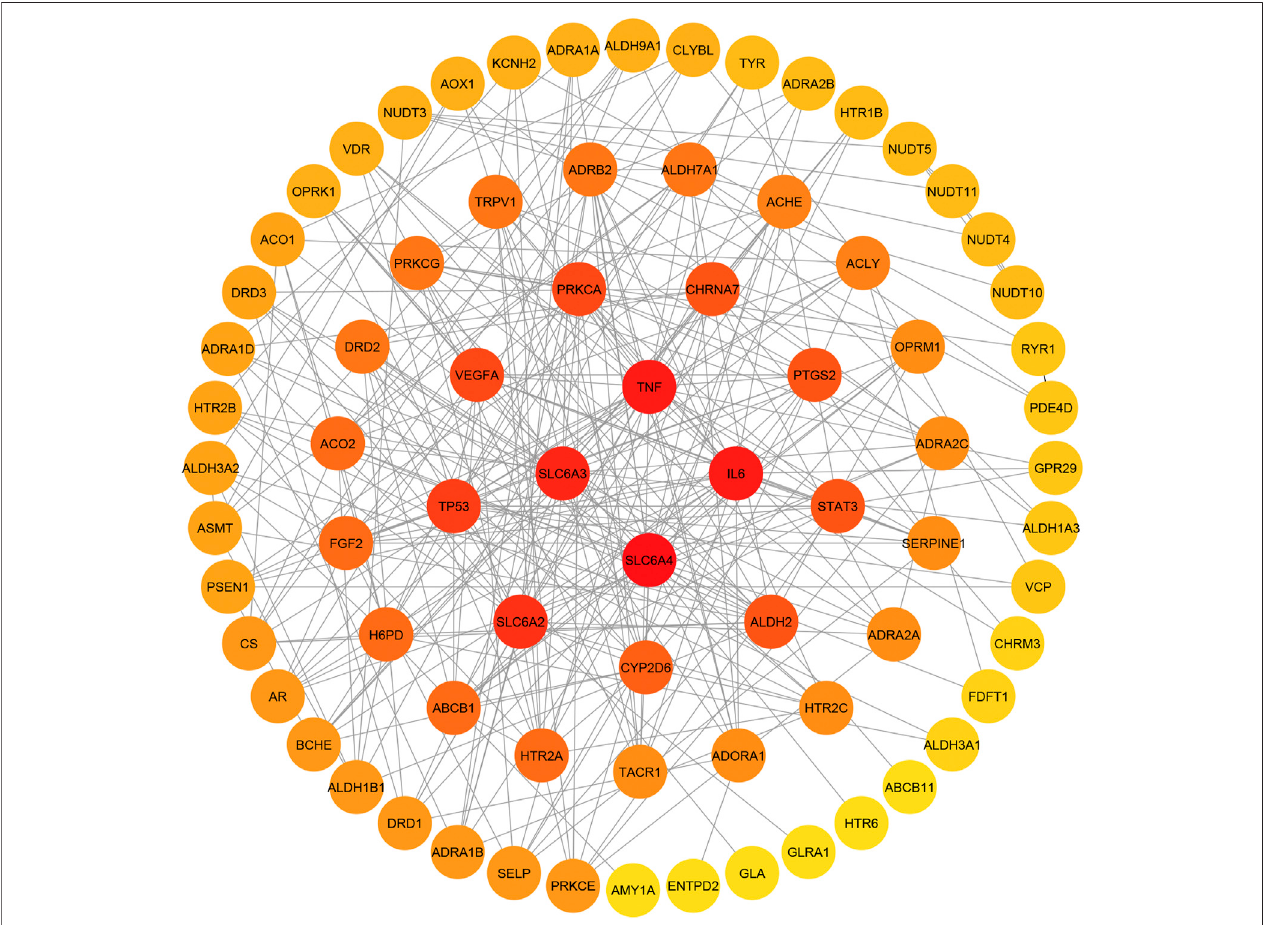
FIGURE 7 | Potential target interaction network (PPI). The color of the circle changes from red to yellow to represent the change of the degree value of the target point from large to small; the four target points in the center have the largest degree values.